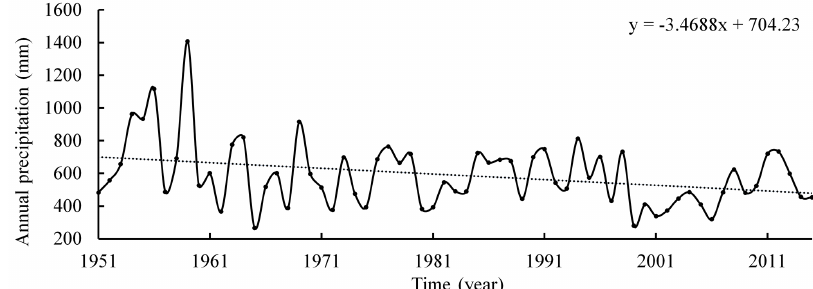
Figure 1. Annual precipitation time series from 1951 to 2015 at Beijing